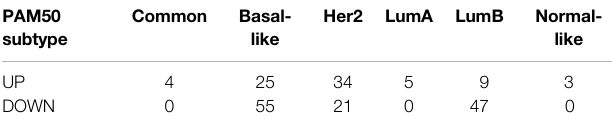
TABLE 1 | Number of common and speci fi c DEGs in the breast cancer subtypes. PAM50 subtype